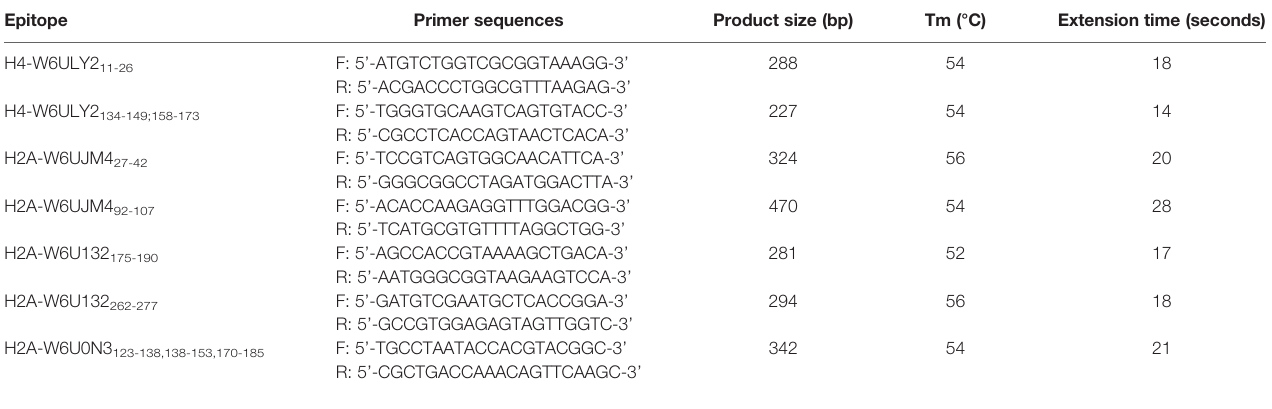
TABLE 1 | Primer sequences used for amplifying epitope sequences by PCR.